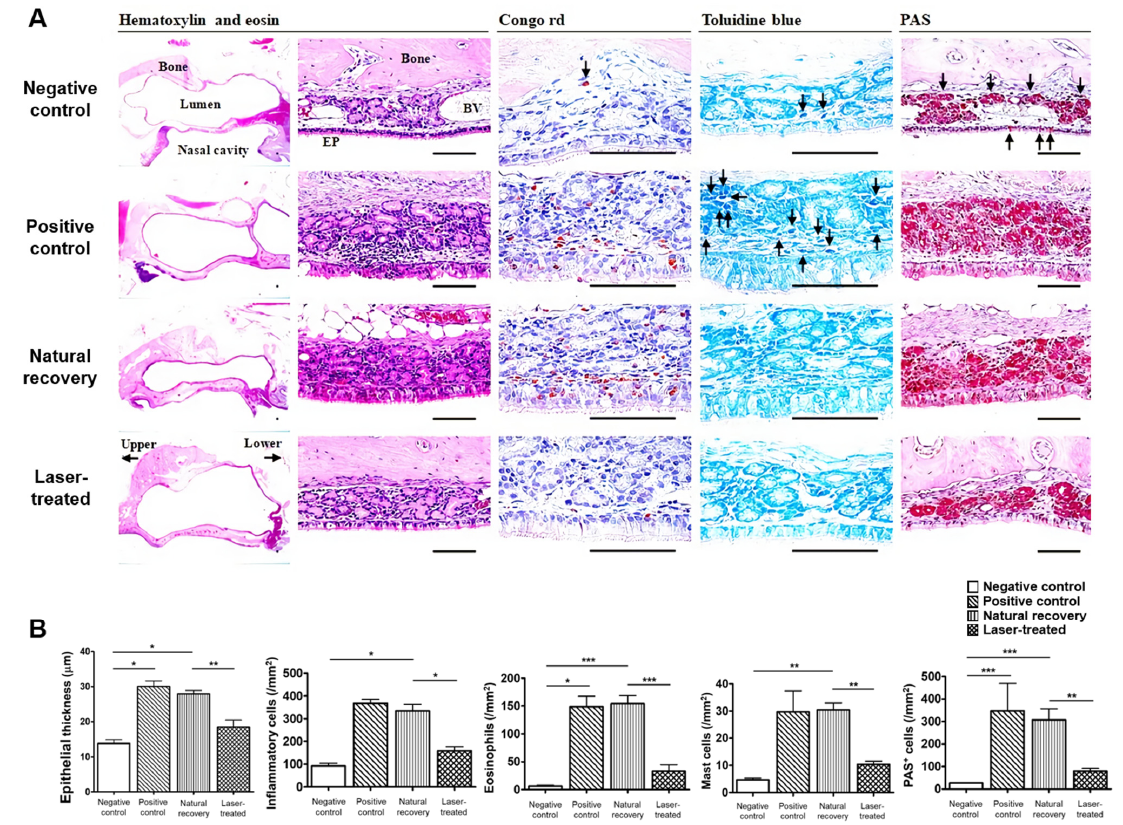
Figure 2. Representative histopathological images of the sino-nasal mucosa according to groups ( A ). Quantitative data of histopathology in the sino-nasal mucosa among all groups ( B ). Data are expressed as the means ± SEMs. * p < 0.05, ** p < 0.01, *** p < 0.001. Scale bars = 80 µ m. Upper and lower means head to oral cavity direction. (Upper indicated head direction whereas lower indicated oral cavity direction) Arrows and dot colors indicate eosinophils in Congo red stains, Mast cells in Toluidine blue stains and goblet cells in PAS